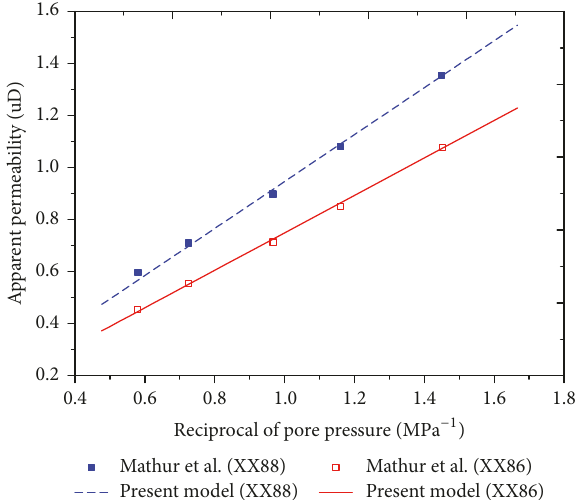
Figure 4: Permeability ratio as a function of pore pressure. The solid line is calculated from (11), and the dash dot line is calculated from (12). The parameter set is presented in Table